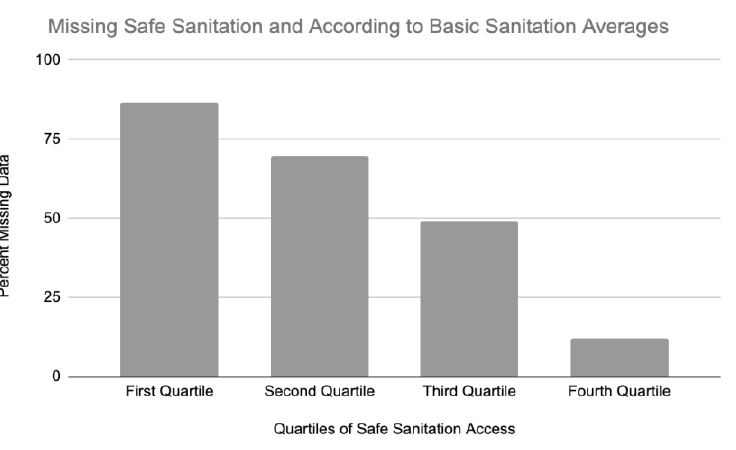
Figure 4. Missing Safe Sanitation Access according to Basic Sanitation Averages.